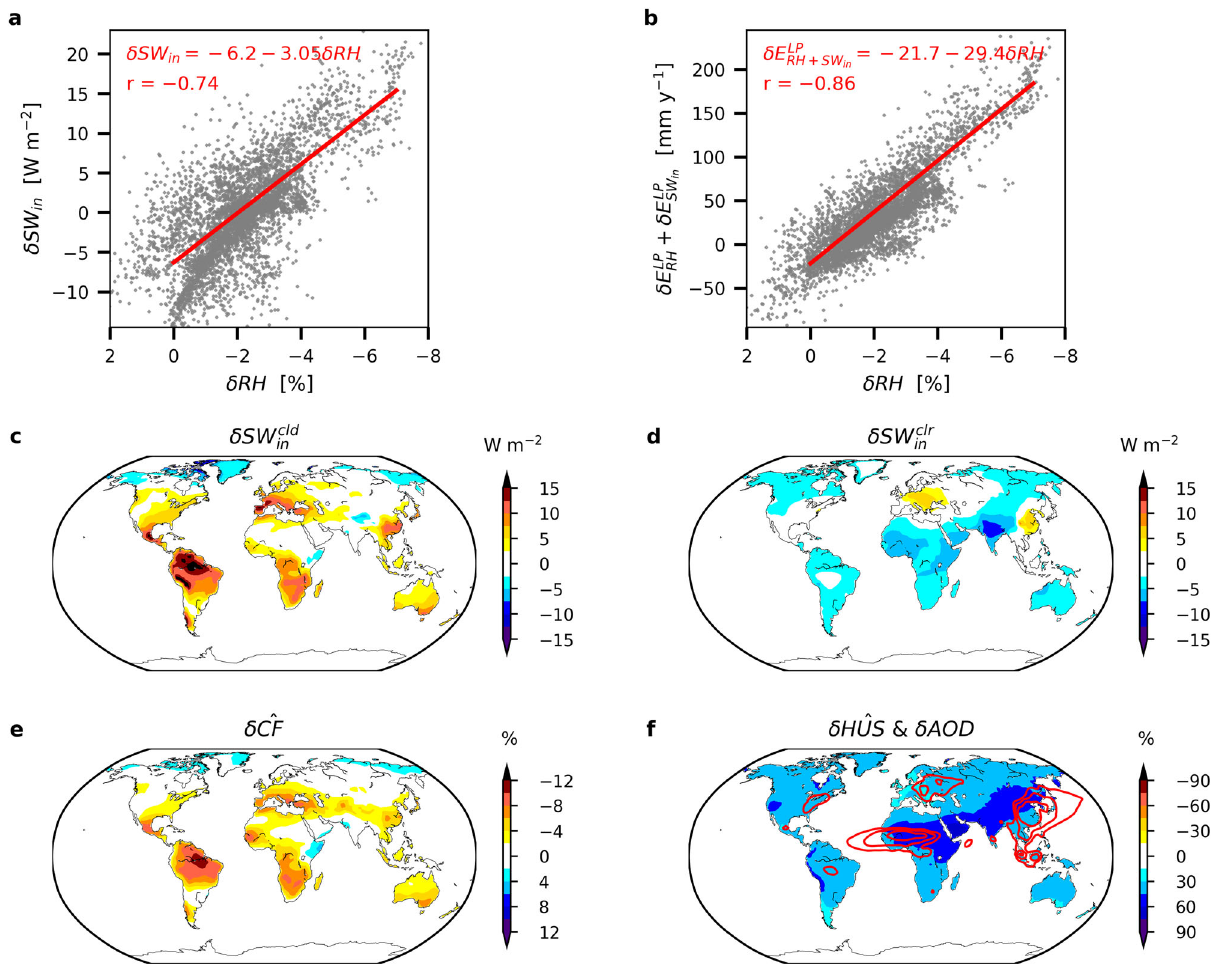
Fig. 4 The collective effect of regional hydroclimate change on lake evaporation through coupled changes in surface relative humidity and incoming shortwave radiation. a Scatterplot between future changes in surface relative humidity ( δ RH ) and incoming shortwave radiation ( δ SW in ). b Scatterplot between δ RH and δ E LP RH þ SW , i.e., the combined evaporation changes due to δ RH and δ SW in estimated by the LP equation. c Changes in the cloud shortwave in effect. d Changes in the clear-sky incoming shortwave radiation. e Changes the cloud fraction. f Changes in the aerosol optical depth (contours; levels at 0.05, 0.1,0.2, 0.4) and column-integrated water vapor content. The cloud fraction and the integrated vapor content have been normalized (denoted by the hat symbol) by solar insolation at the top of the